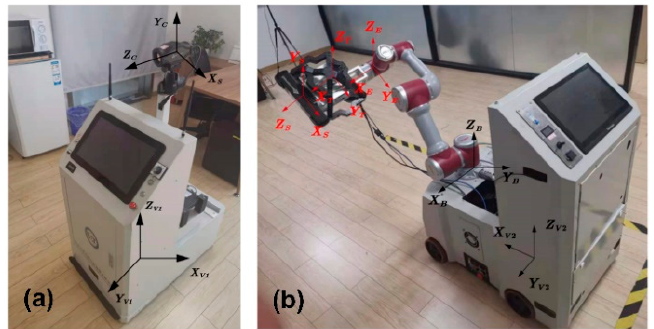
Figure 4. Schematic diagram of the coordinate system of the mobile measurement system. ( a ) Visual tracking coordinate system ( b ) Manipulator and scanning measurement coordinate system.